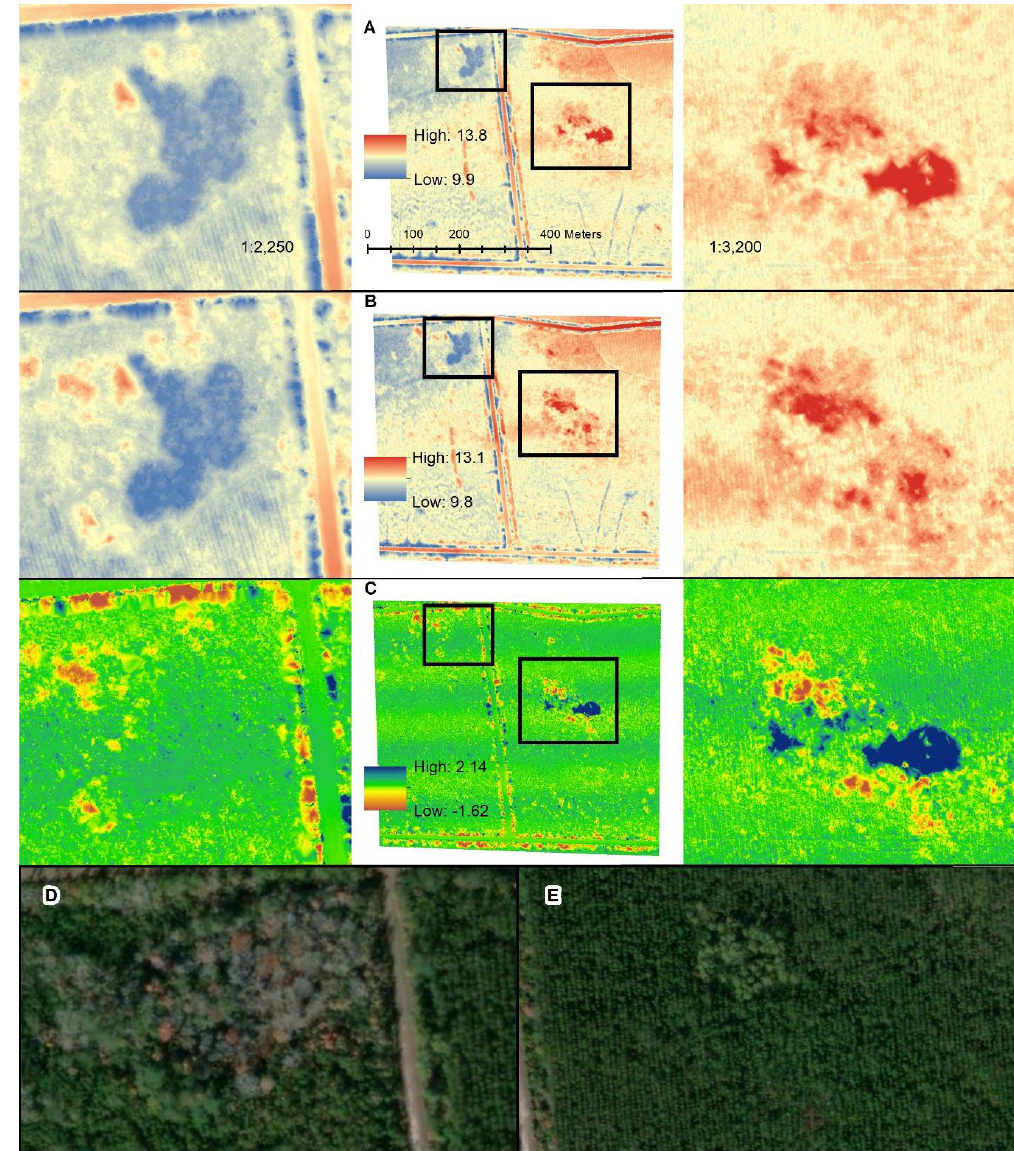
Figure 7. Digital Terrain Models of the Quanergy M8 ( A ) and Velodyne HDL-32E ( B ) LiDAR